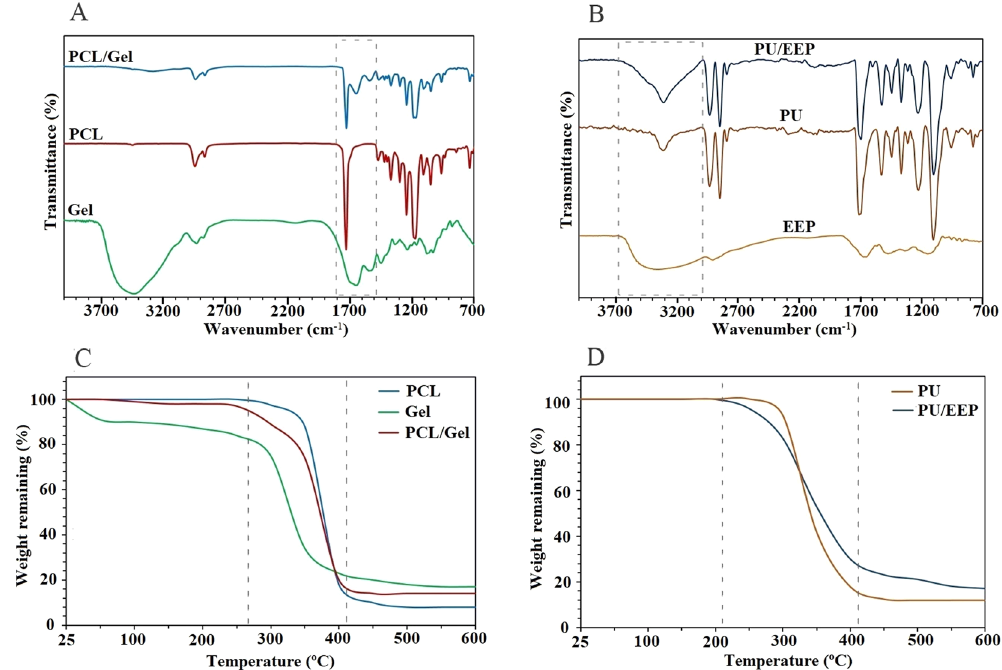
Figure 2. The ATR-FTIR spectra of ( A ) the sublayer and ( B ) the top layer. The TGA graphs of ( C ) the sublayer and ( D ) the top